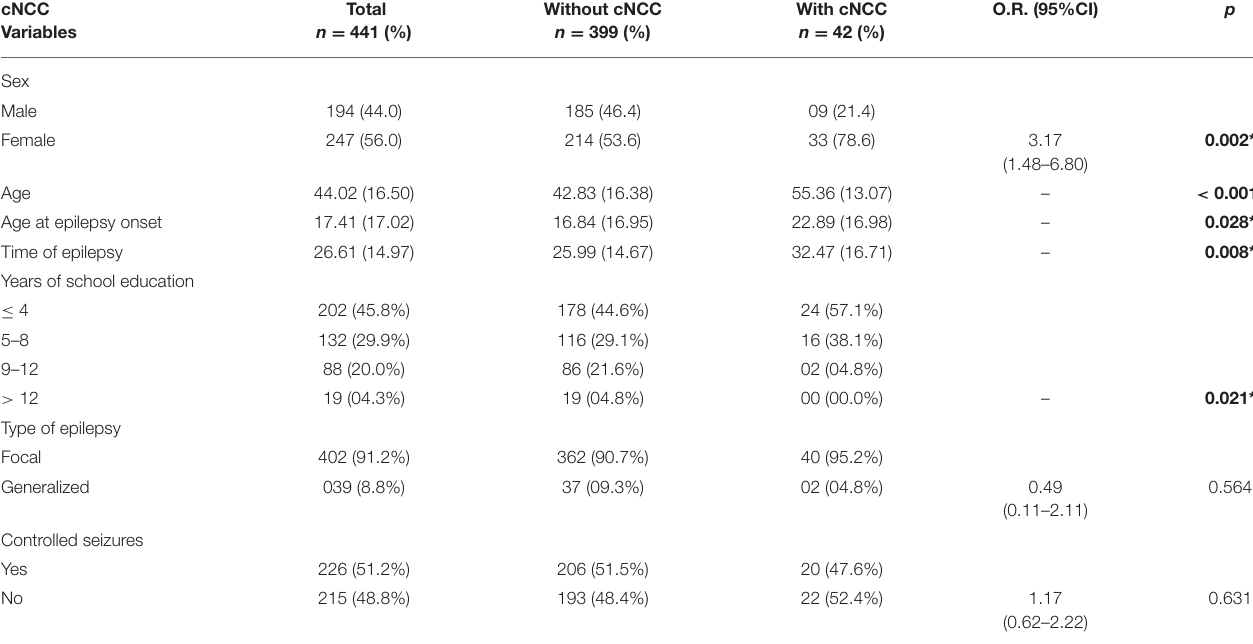
TABLE 3 | Demographic variables—only patients with complete